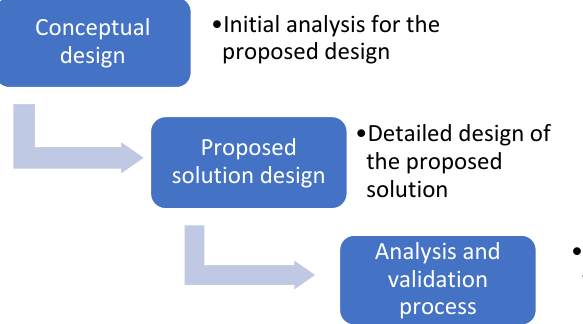
Figure 1. Flow chart with all the methodological steps .